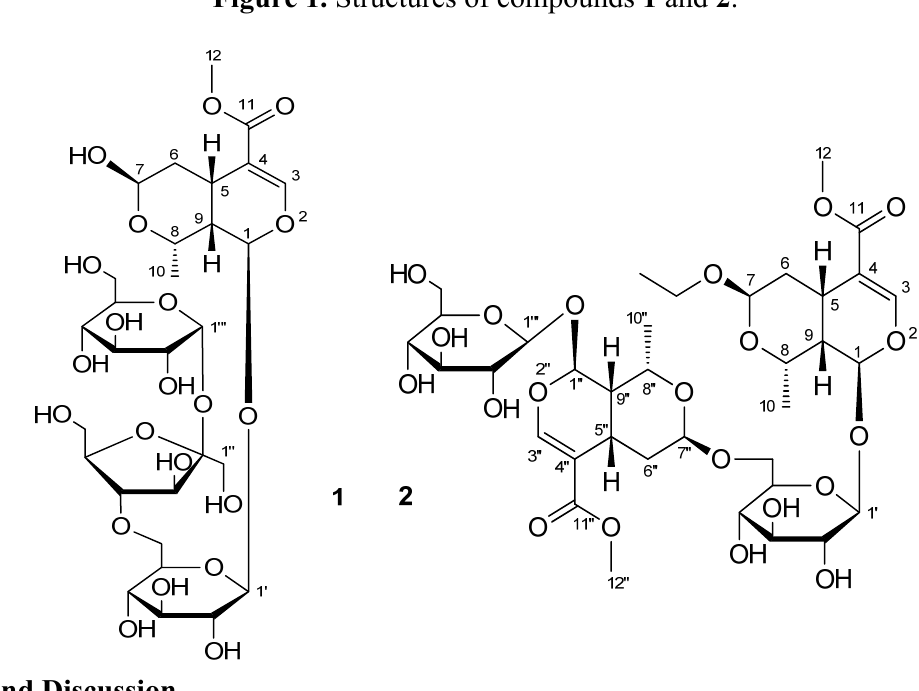
Figure 1. Structures of compounds 1 and 2